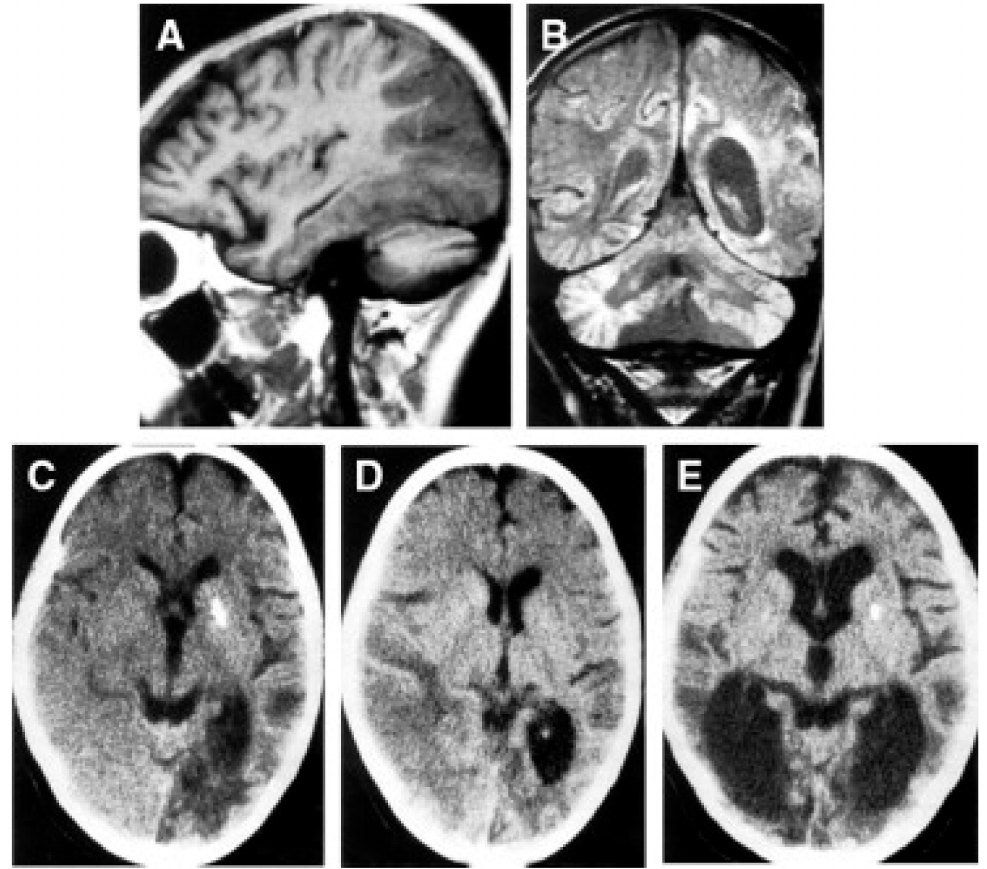
Figure 8. Brain MRI of a MELAS case, a 14-year-old girl. Sagittal T1-weighted section ( A ) of the left cerebral hemisphere shows a vast posterior lesion. A proton-density coronal section ( B ) shows, in addition to the temporo-occipital lesion, bilateral lesions, and atrophy of the cerebellar cortex. Serial CT scan examinations ( C – E ) show a reduction of the left temporal-occipital lesion (from C to D) but the appearance of a new lesion in the right temporo-occipital region ( D ). Two years later, there is marked bilateral atrophy of the posterior cerebral region ( E ). As is frequently observed in MELAS patients, as well as in other mitochondrial disorders, calcium deposits are detected in the left putamen ( C , E ). Adapted from